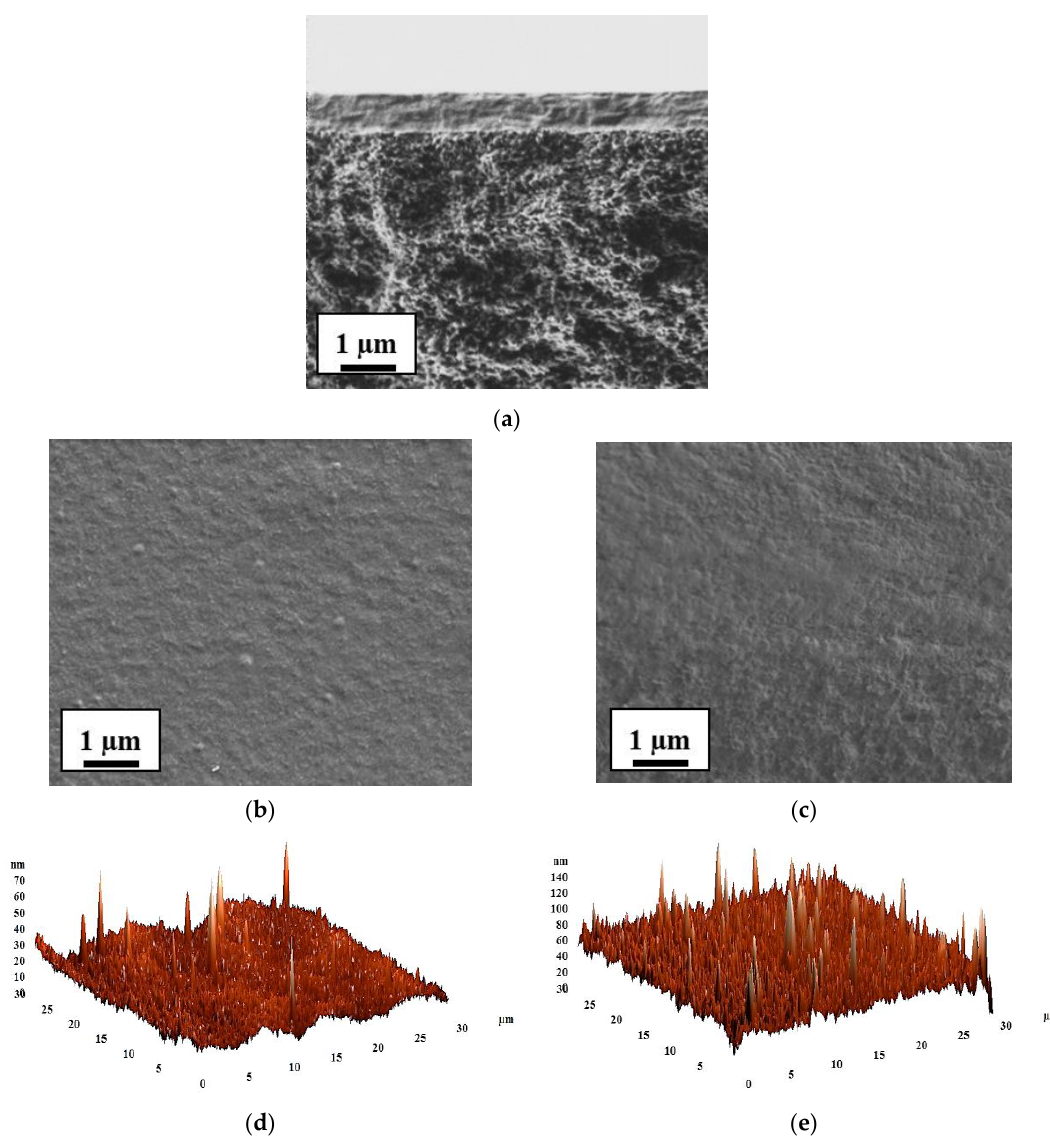
Figure 10. The cross-sectional SEM micrograph ( a ) and SEM micrographs of surface and AFM images of cross-linked supported ( b , d ) SA-0/PAN CaCl2 and ( c , e ) SA-5/PAN CaCl2 membranes.